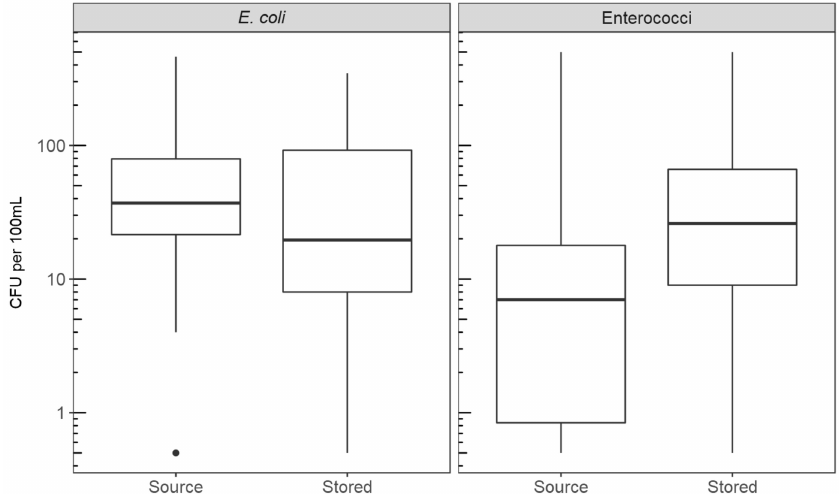
Figure 3. Boxplots of the concentrations (CFU / 100mL) of E. coli (left) and enterococci (right) in the source and stored water samples. The midline of the box represents the median of the data, with the upper and lower bounds of the box showing the first and third quartile. The whiskers show the extremes of the data that are within 1.5 times the interquartile range. Any data points outside this range are plotted as outlier circles (one outlier for E. coli concentration in source water).